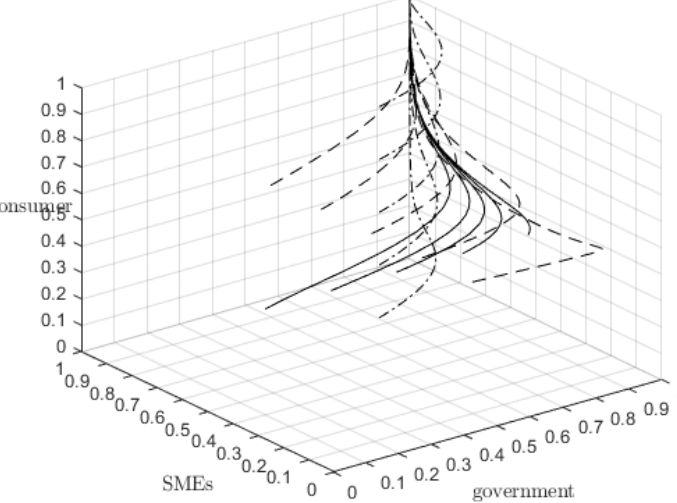
Figure 3. Before a public health emergency, the government regulatory agencies–SMEs–consumers (Three-dimensional stereogram).